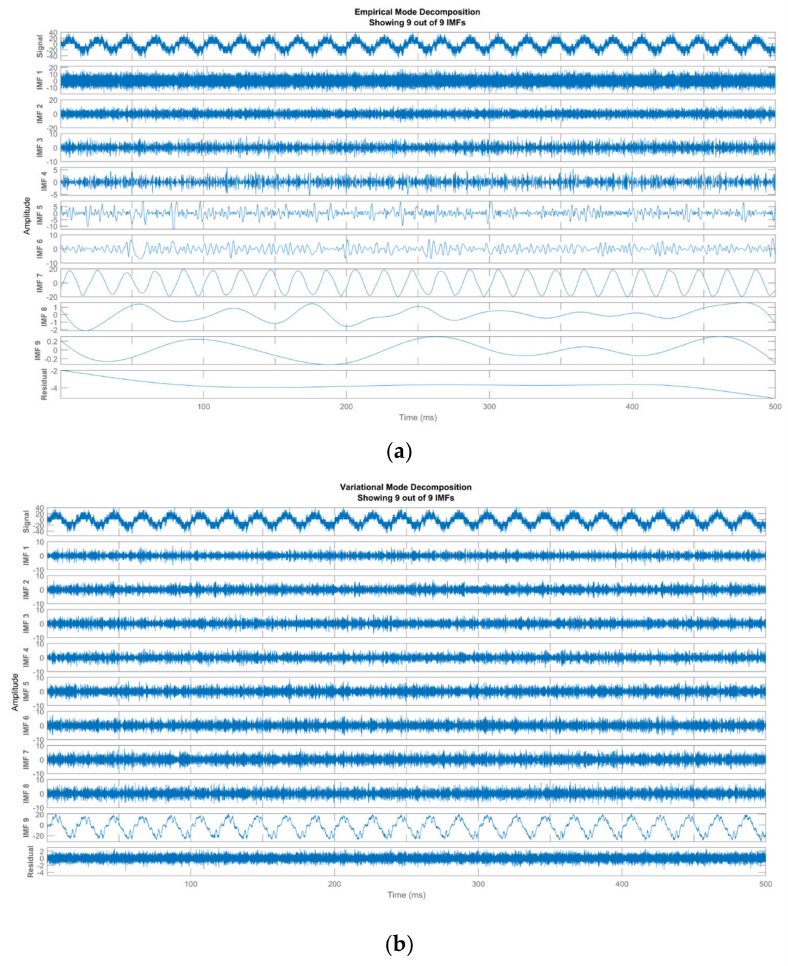
Figure 9. EMD ( a ) and VMD ( b ) decomposition of synthetic ester liquid current signal under disc electrode arrangement (d = 2.5